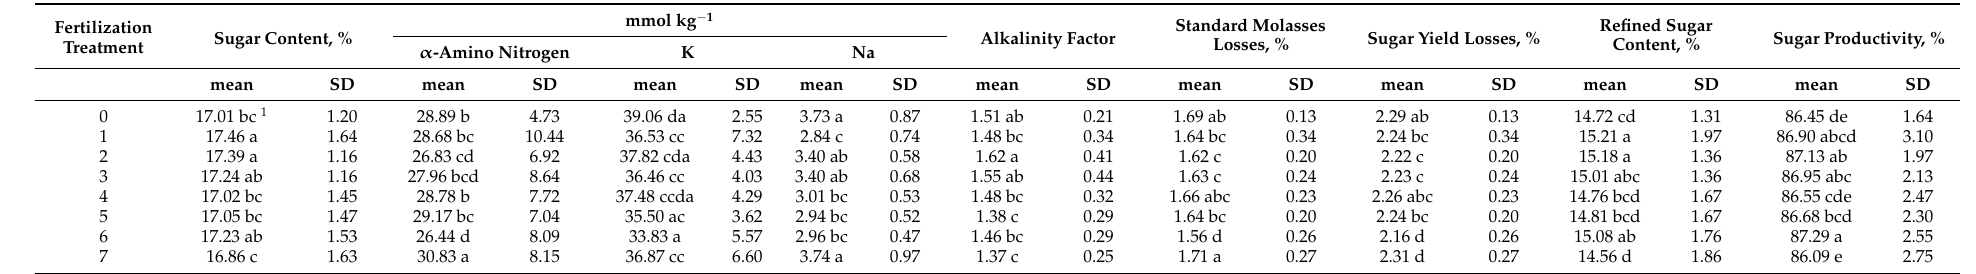
Table 2. Means and standard deviations (SD) of technological quality of sugar beet roots (from 2018 to 2020). Fertilization